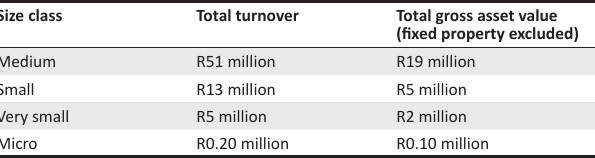
TABLE 1: Total turnover and gross assets of furniture manufacturing